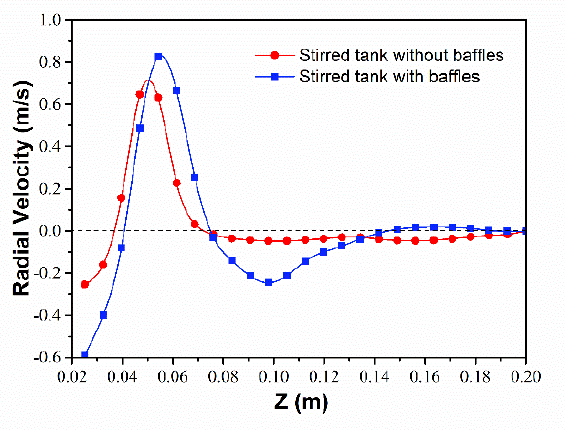
Figure 19. Comparison of σ of stirred tank with and without baffles.